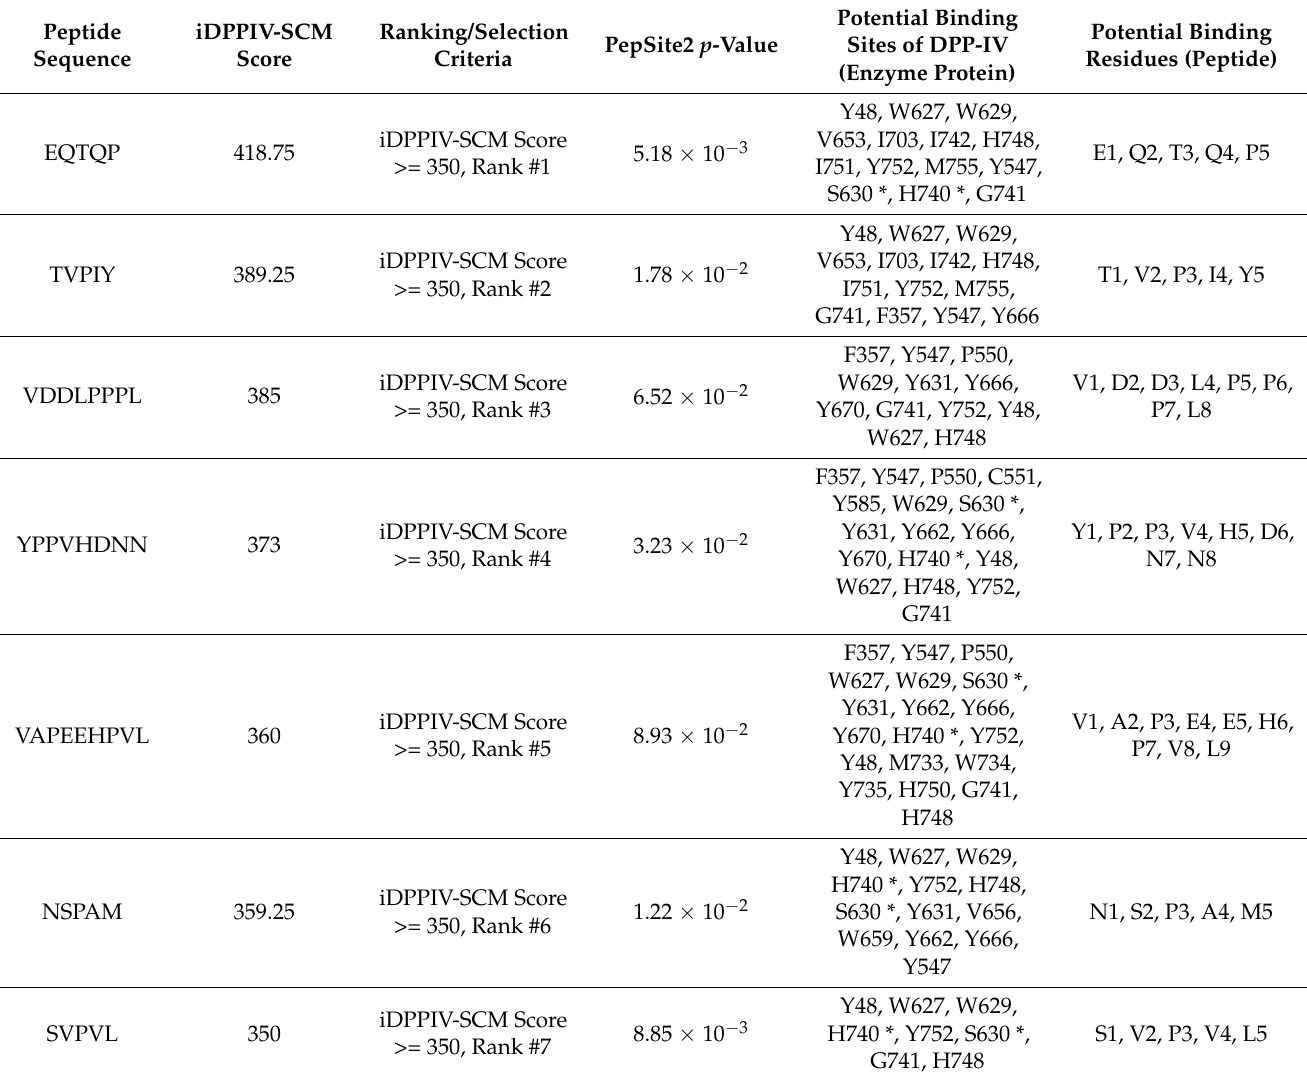
Table 5. PepSite2 analysis using DPP-IV (PDB: 2ONC) as the target